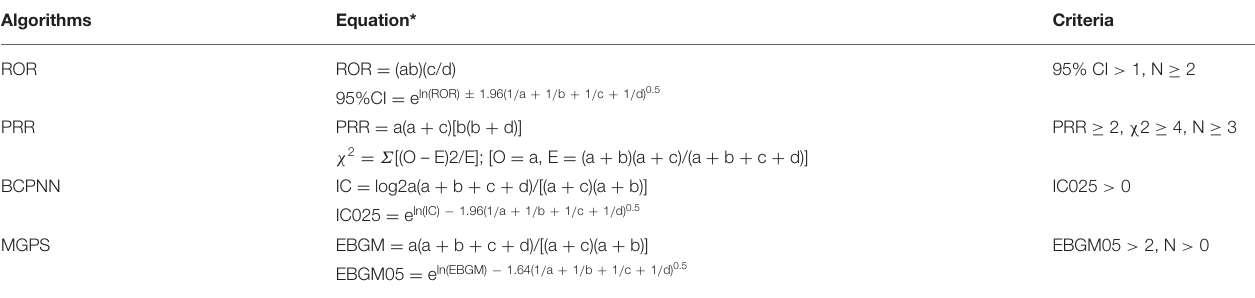
TABLE 1 | Summary of major algorithms used for signal detection. Algorithms